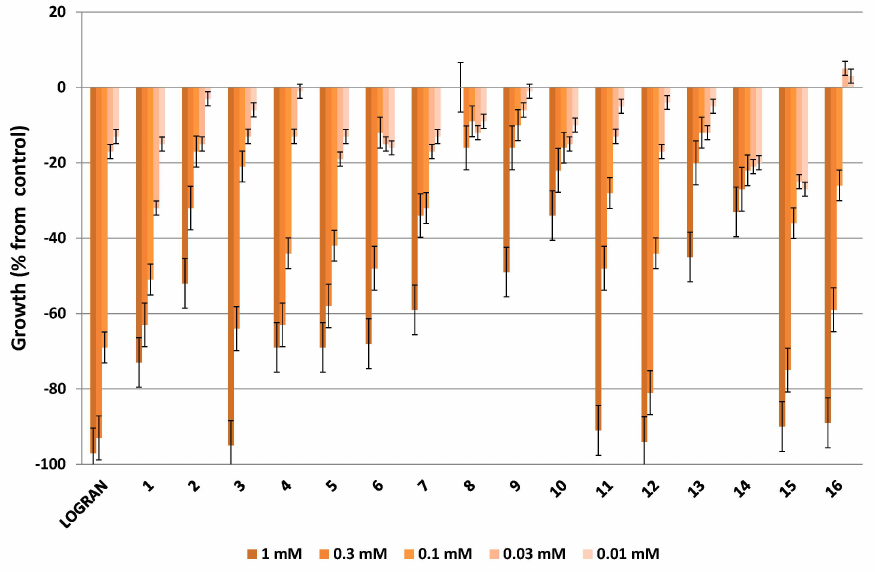
Figure 6. Effect of compounds 1 – 16 from the bioactive fractions of the different extracts of Citrus sinensis on the elongation of etiolated wheat coleoptiles. Values are expressed as percentage difference from